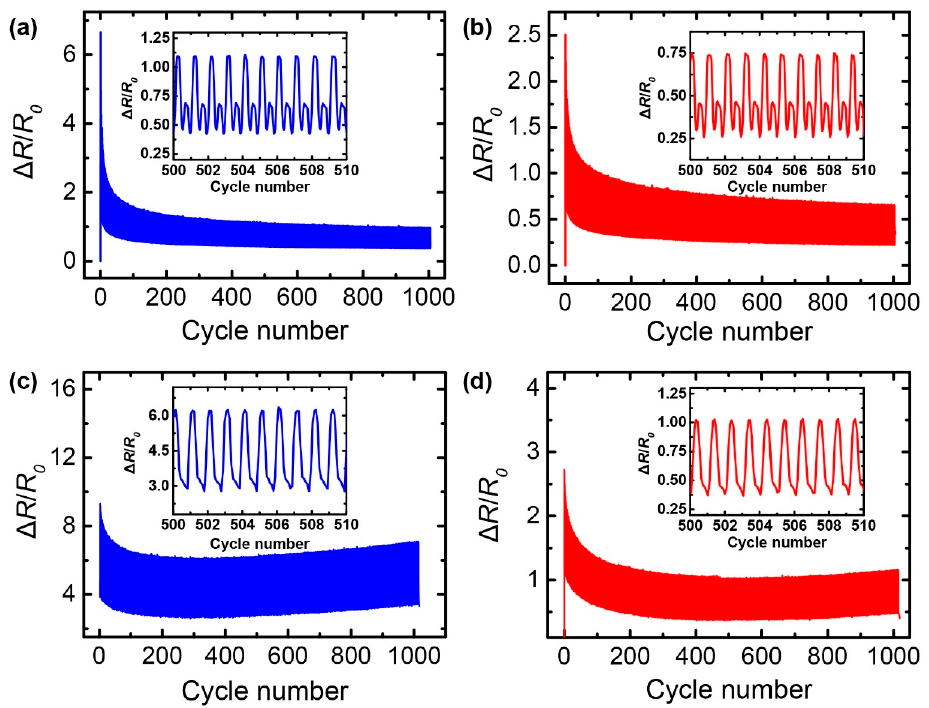
Figure 7. Resistance-strain responses of the: ( a , c ) G/SpX; ( b , d ) G/AgNW/SpX composite strain sensors under 1000 stretching–releasing cycles with a strain of 10%; ( a , b ) Without pre-strain; ( c , d ) With 10% pre-strain. The insets show the detailed responses of the sensors.